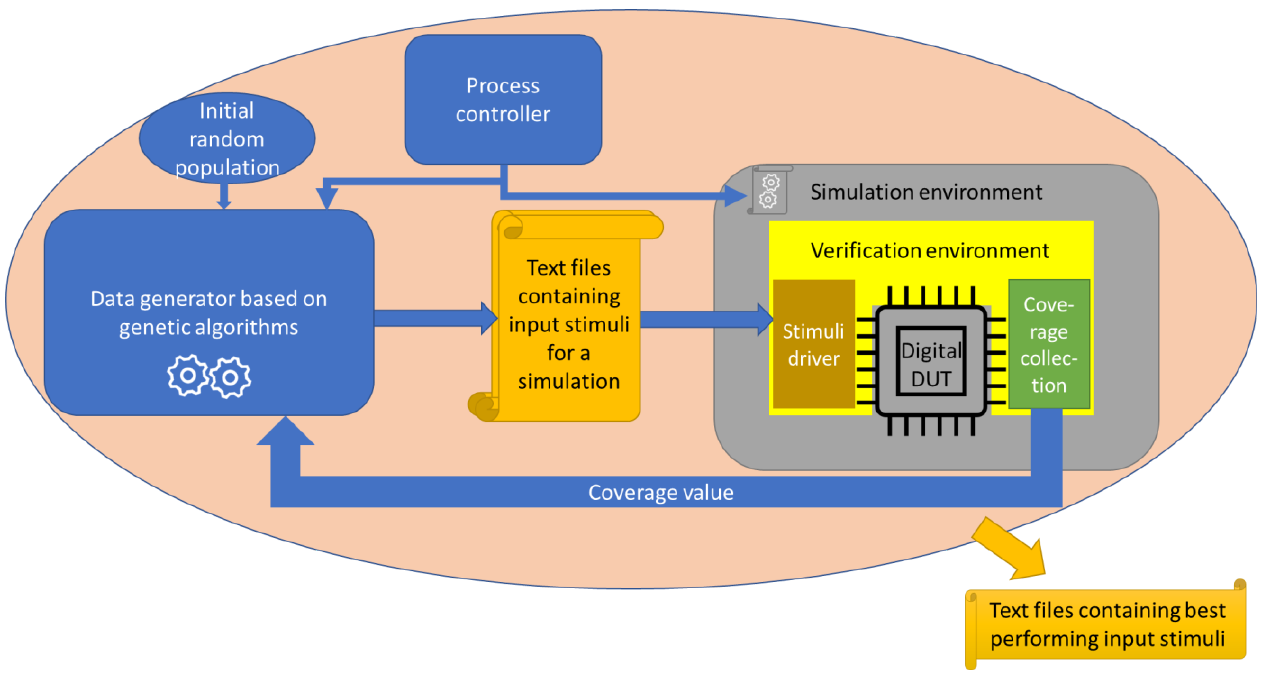
Figure 7. Schematic of the programming ecosystem used to generate high-performance input stim- uli.